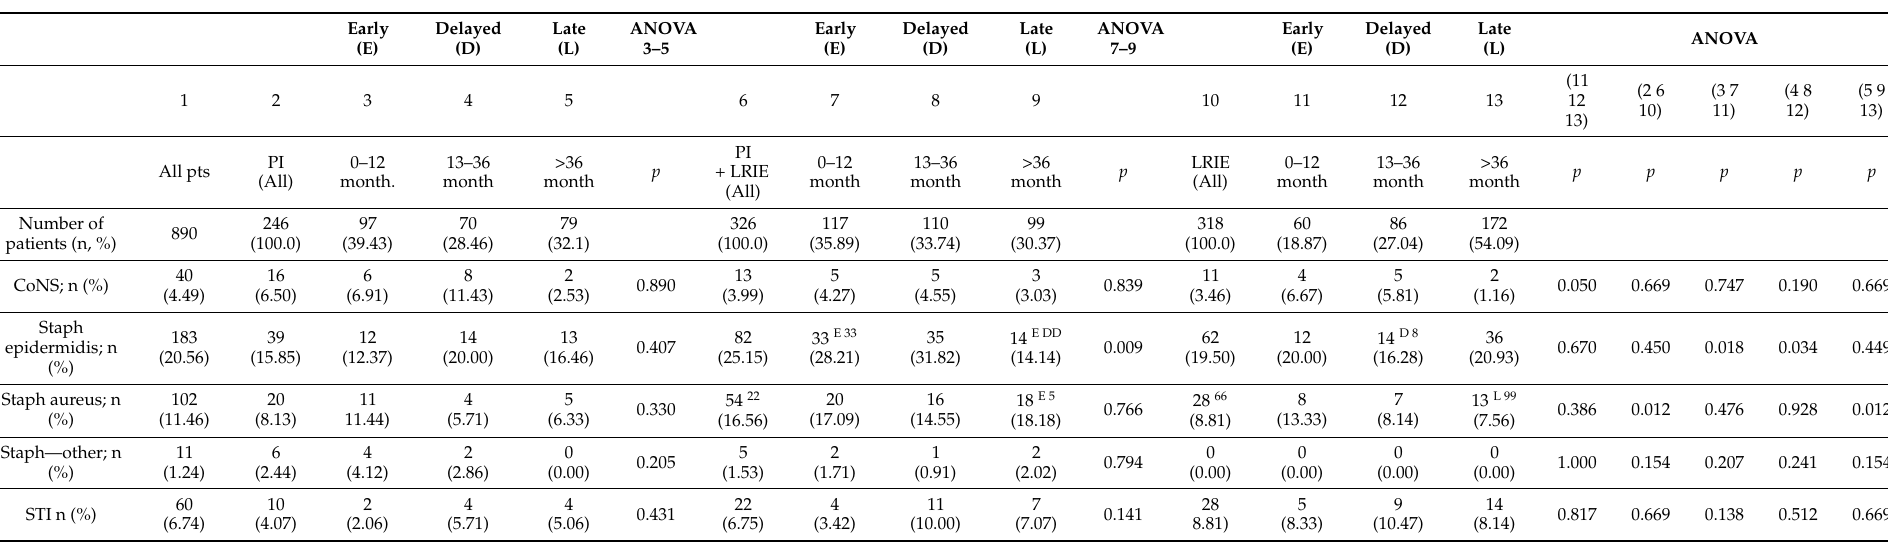
Table 3. Distribution of culture pathogens depending on type of infection and temporal onset related to last CIED procedure for noninfectious